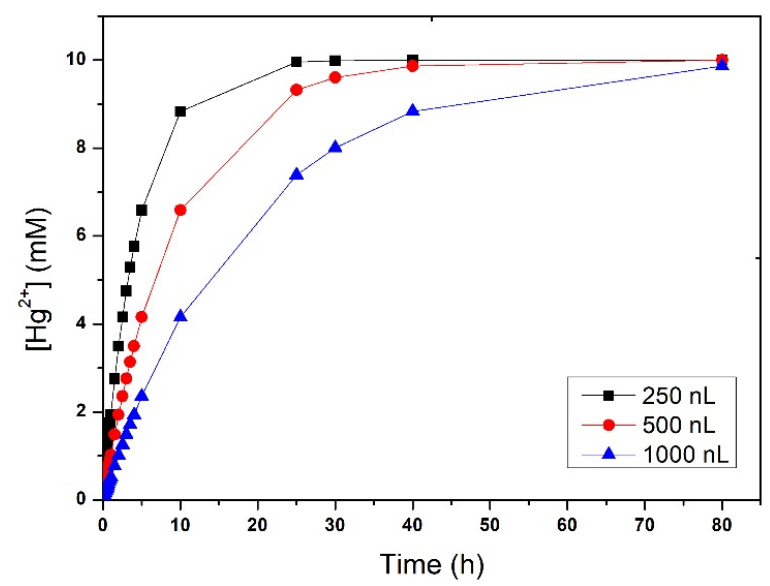
Figure 8. Evolution of Hg 2+ concentration in the protein solution.